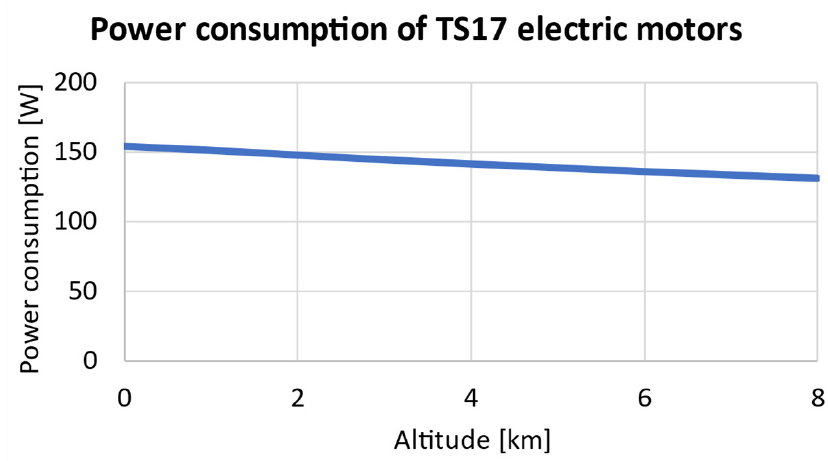
Figure 19. Power consumption of TS17 electric motors during climbing.